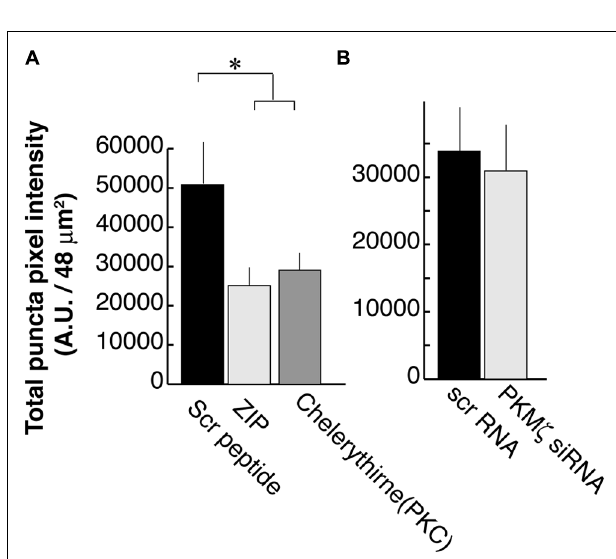
manner as data presented in Figure 2 .The graphs show averaged PSD-95 intensities in somata (A) , total pixel intensities of PSD-95 puncta (B) , and puncta intensities normalized to somal intensities (C) . In each condition, 16 branches from eight cells were analyzed. Error bars represent SEM.